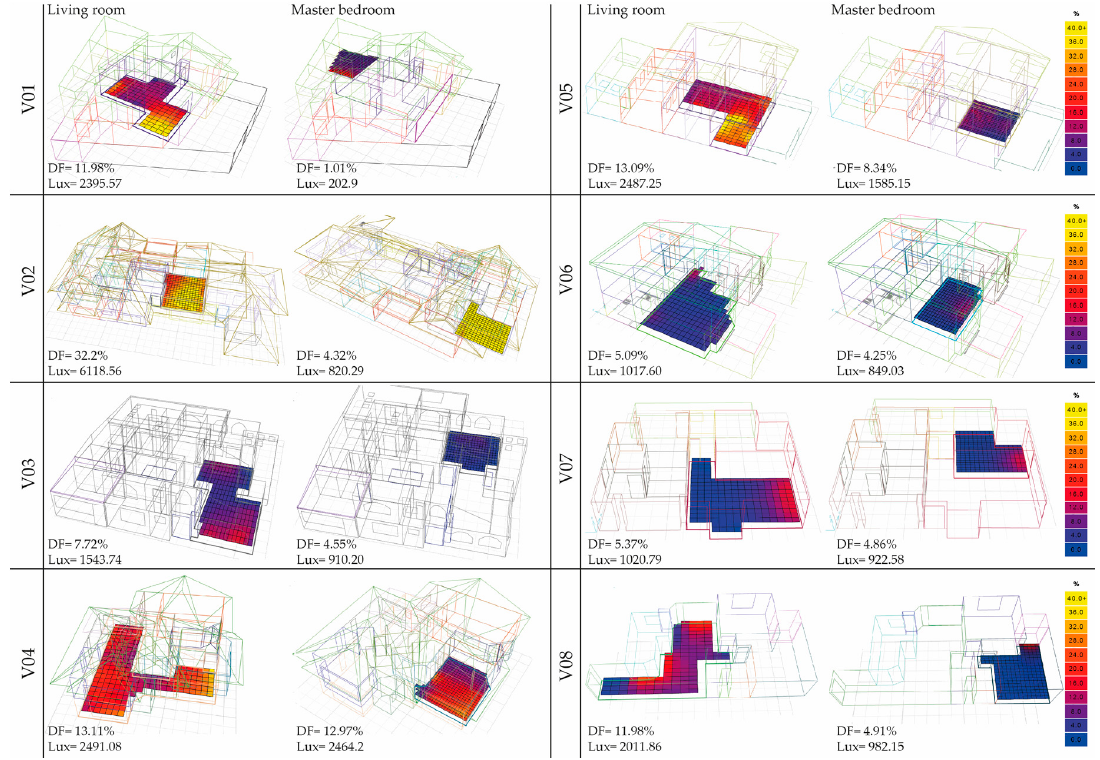
Figure 10. Daylight factor (DF) of the living room and master bedroom, obtained from simulations performed in the studied houses. Data from: Simulations.